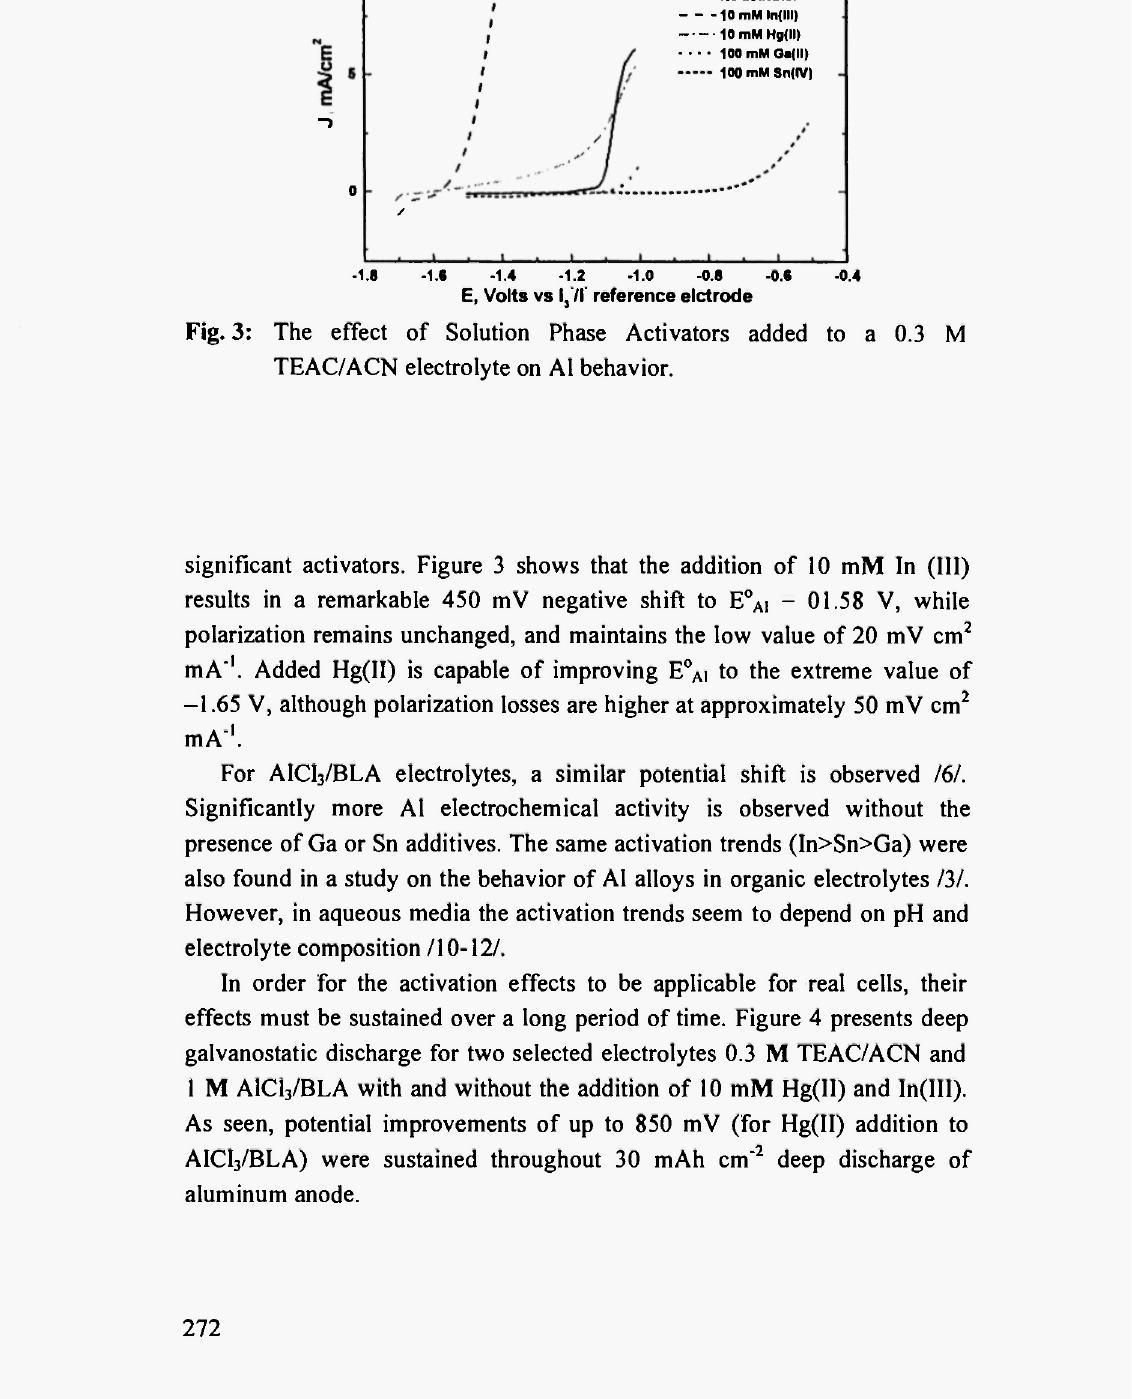
Fig. 3: The effect of Solution Phase Activators added to a 0.3 Μ TEAC/ACN electrolyte on Al